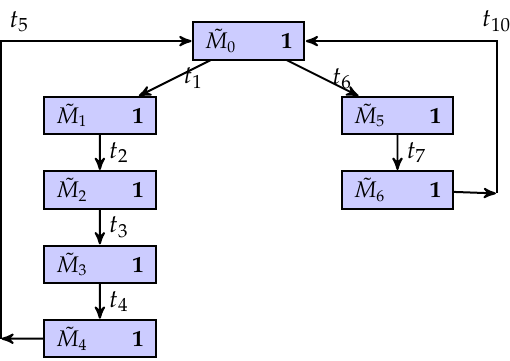
Figure 13. The BCG-based